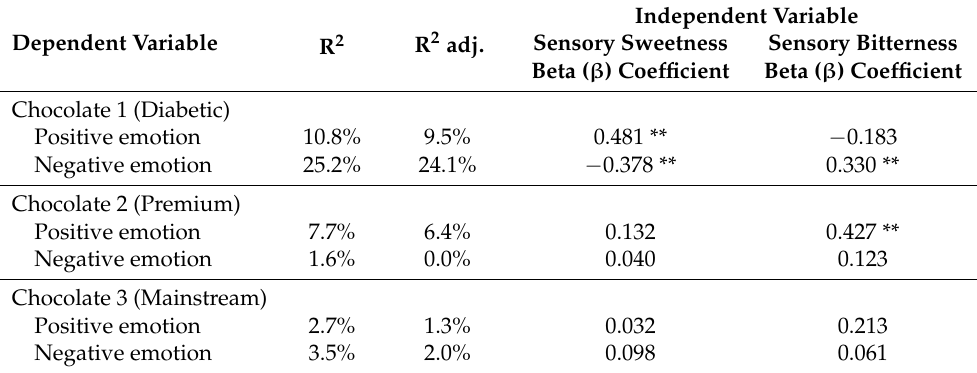
Table 4. Multiple regression analysis between emotion and sensory